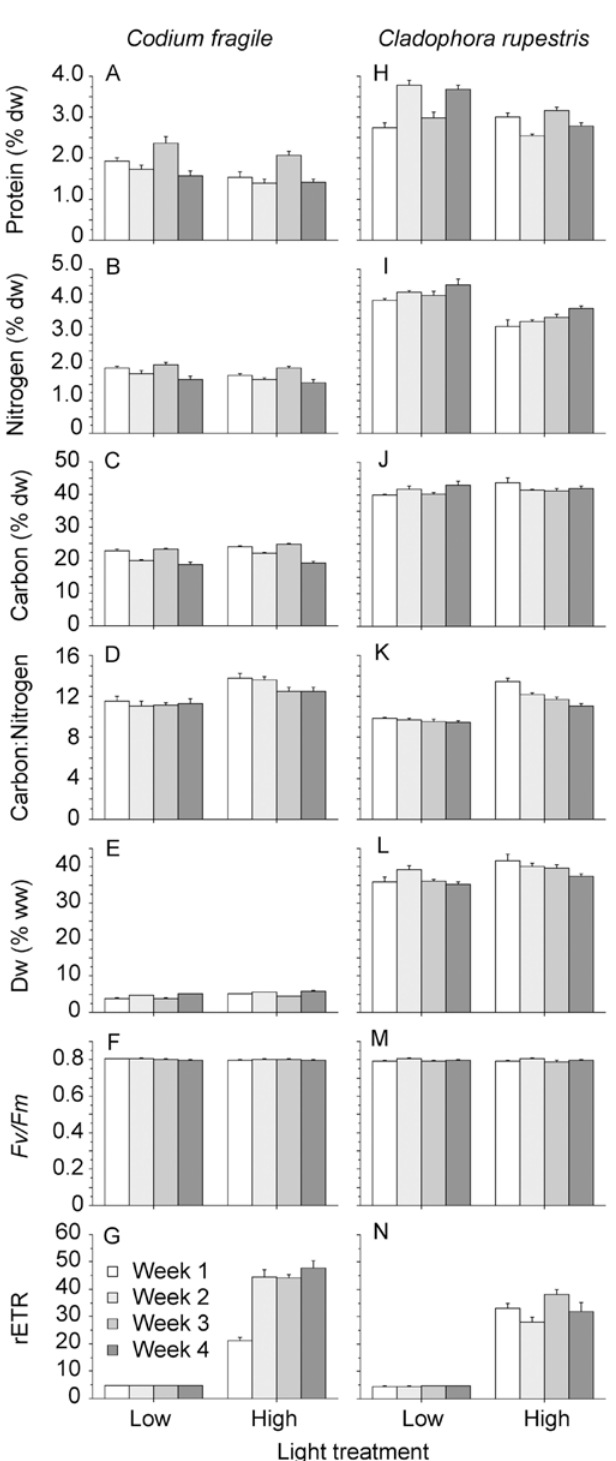
Fig 3. A and H) protein content (% dry weight), B and I) nitrogen content (% dry weight), C and J) carbon content (% dry weight), D and K) carbon:nitrogen ratio, E and L) dry weight (% wet weight), F and M) maximum quantum yield ( F v / F m ), and G and N) relative electron transport of photosystem II (rETR) of the two algal diets Codium fragile (A-G) and Cladophora rupestris (H-N) fed to Elysia viridis under low and high light during four-week experiments. Error bars show + SEM (n =